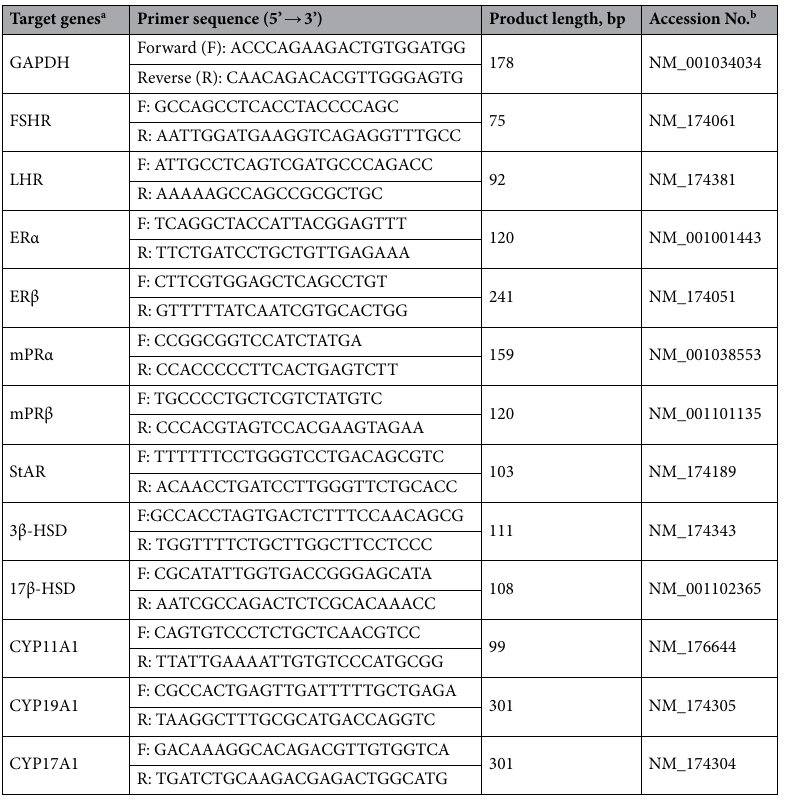
Table 1. The primer sequences of the target genes 36